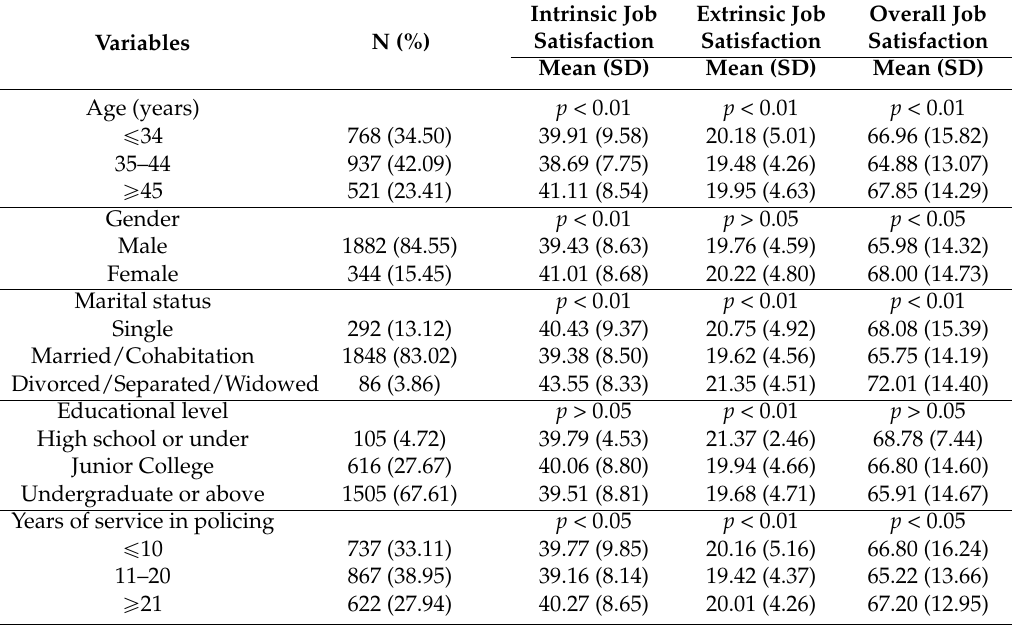
Note: SD: standard